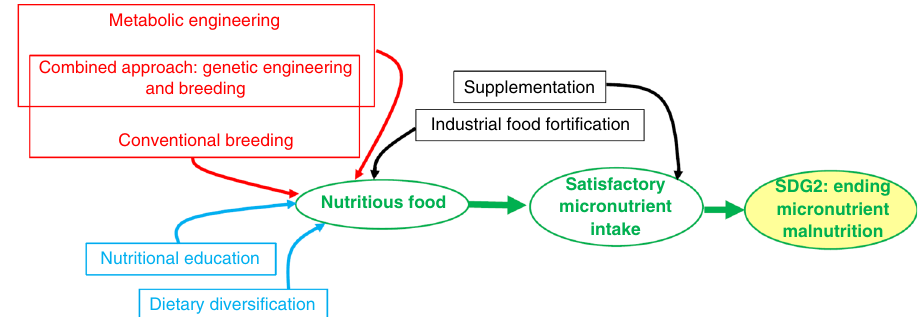
Fig. 3 Ending malnutrition requires concerted efforts from different angles. Bioforti fi cation (red), dietary interventions (blue), and forti fi cation or supplementation (black) can help affected populations to reach suf fi cient micronutrient intake, leading toward eradication of micronutrient